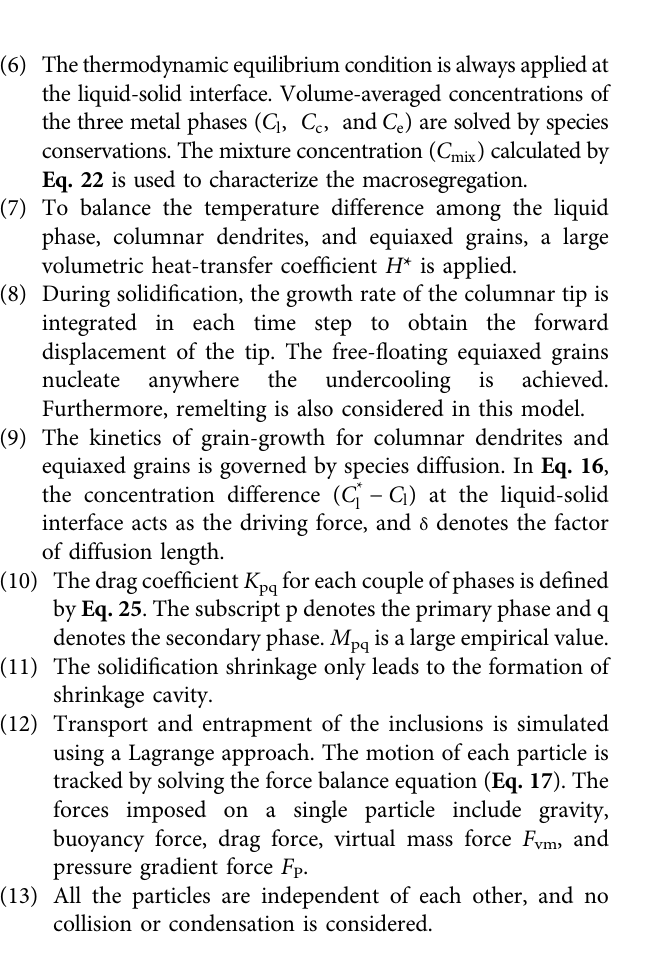
Frontiers in Materials |